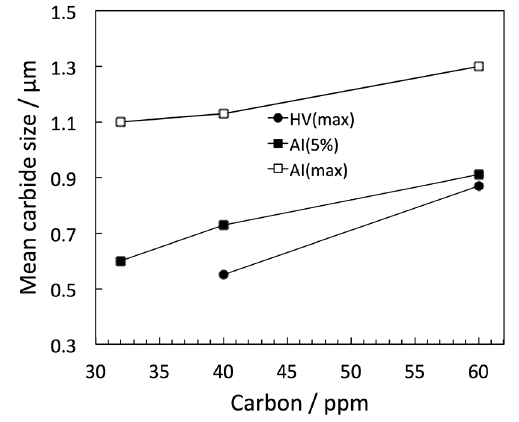
Figure 7. Mean carbide size as a function of carbon content. The experimental data for sample with 32ppm C were obtained from Oliveira et al. 6 for AI(5%) and